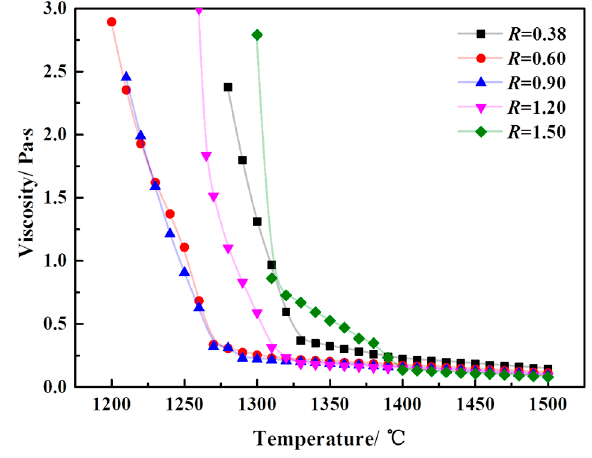
Figure 6. The viscosity-temperature curve of a CaO-SiO 2 -FeO-MgO system at different basicities.